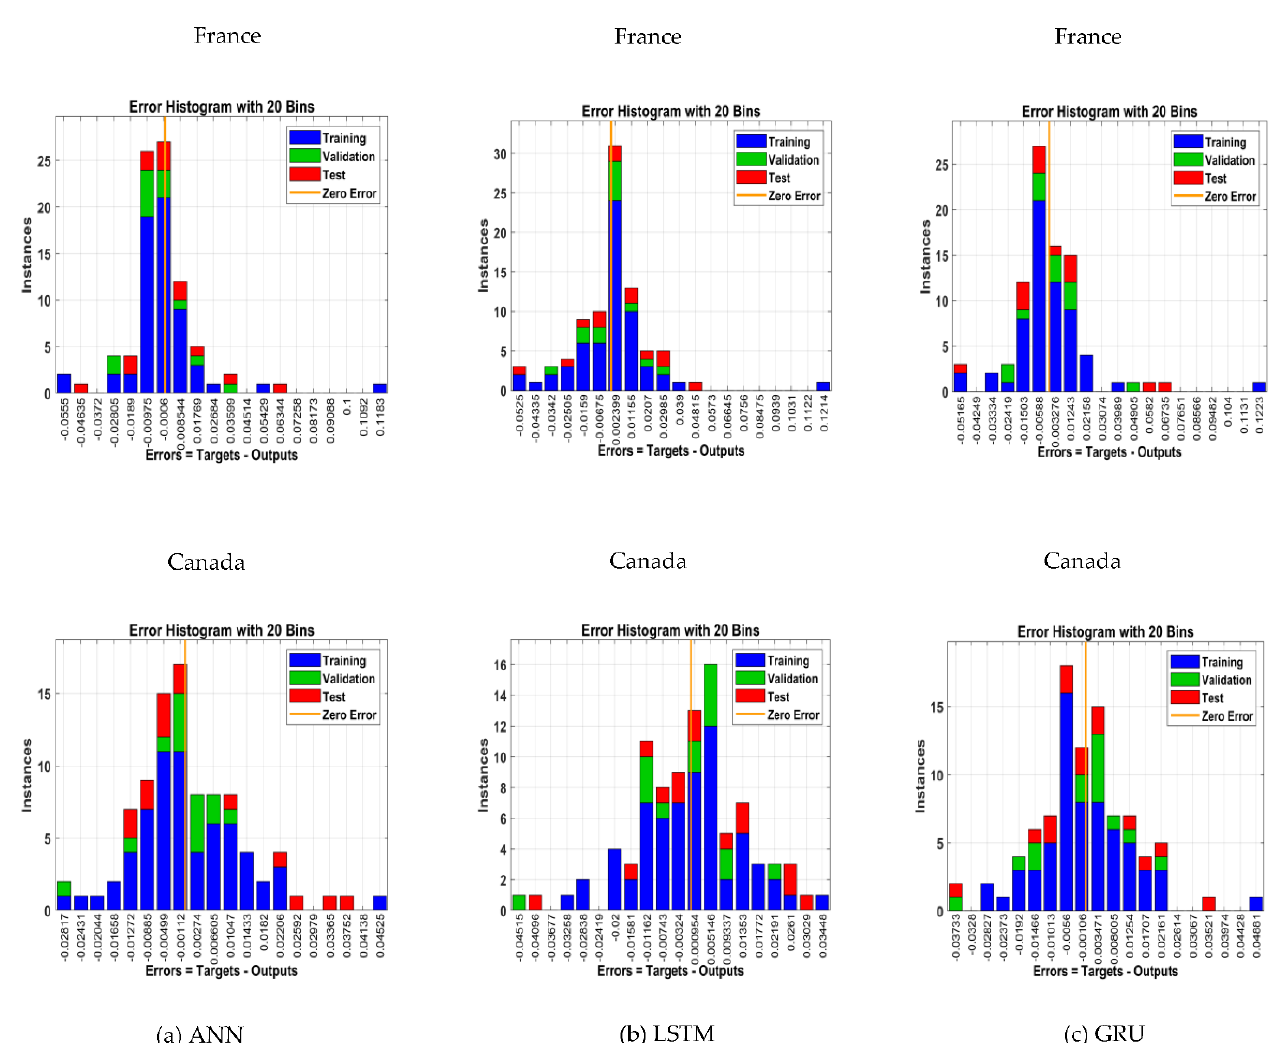
Figure 9. The error histogram of NN optimal model in predicting—monkeypox.